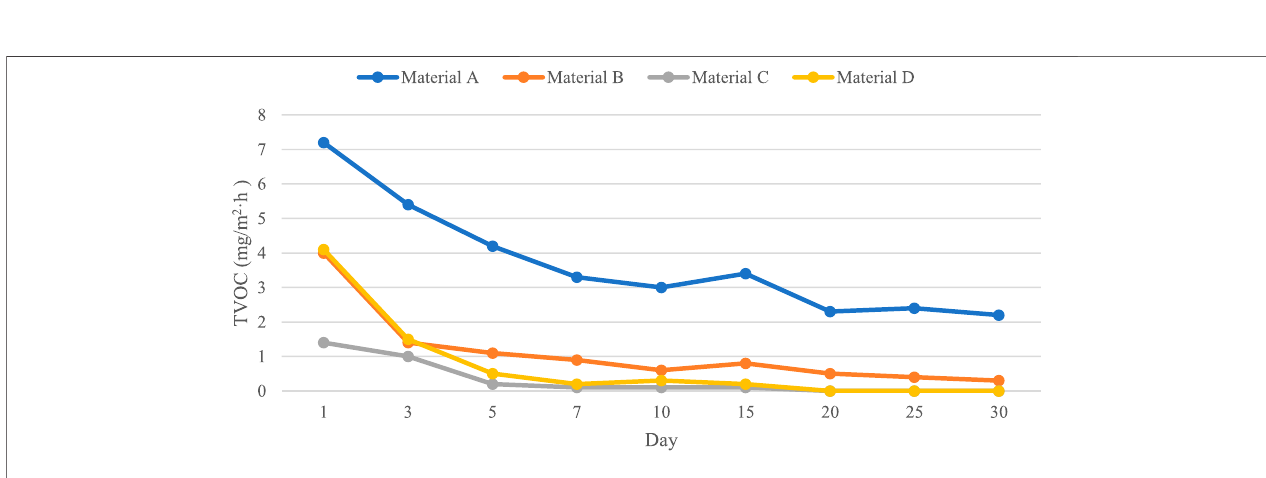
FIGURE 4 | Change of TVOC emission in 30